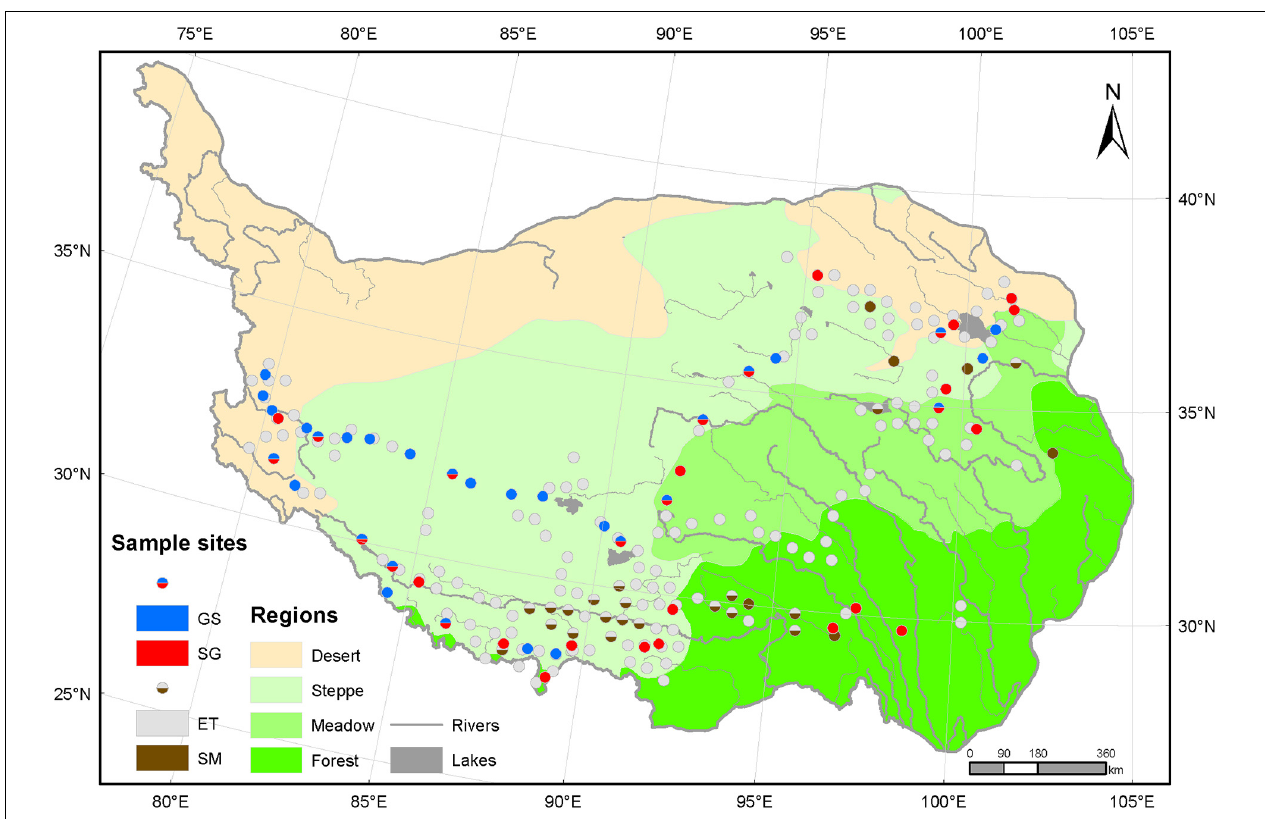
FIGURE 1 | Sample sites on the Tibetan Plateau. Based on the vegetation regionalization scheme, the Tibetan Plateau was modified to four vegetation regions: forest, meadow, steppe grassland, and desert. The raw data for the origin scheme were download from the Resource and Environment Science and Data Center (http://www.resdc.cn). All 218 sample sites were divided into two groups: aquatic plots (170) and terrestrial plots (48). Aquatic plots were tagged as three types: emergent plants (ET) only, submerged plants (SM) only and ET and SM mixed plots, depending on whether a certain group of plants are present or not. The different portions in each terrestrial plot indicated the important values of sedges (SG) versus grasses (GS) and reflect the relative importance of the plant type in this plot. The SG and GS plots in forest region located in alpine meadow belt at high altitude above treeline, and the aquatic plots there were non-forest wetland